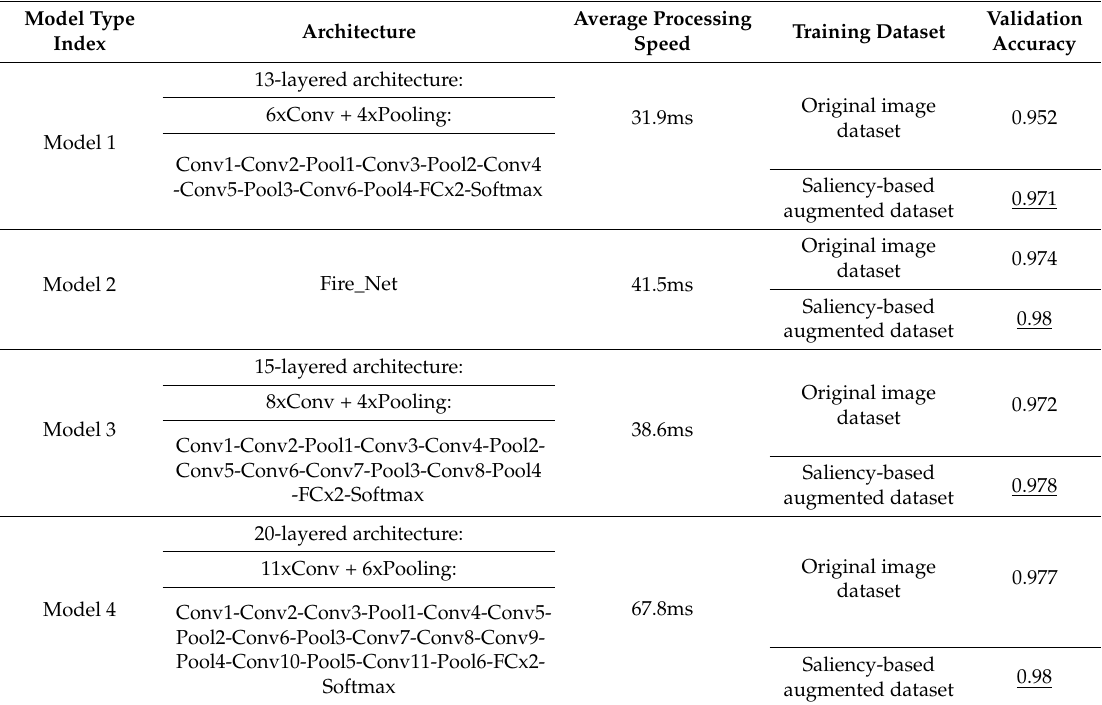
Table 6. Effects of model architecture on performance and runtime.